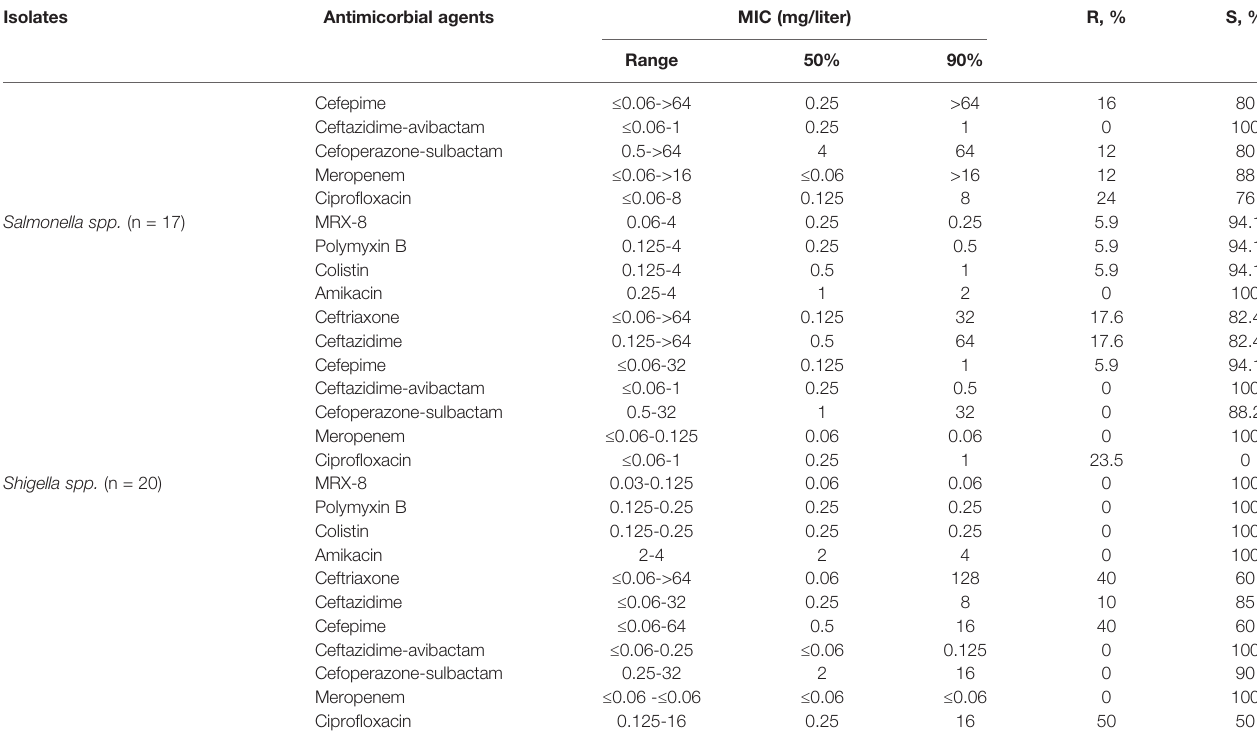
modi fi cation of LPS in outer membrane. Plasmid-mediated lipopolysaccharides (LPS) lipid A component of bacterial cell colistin resistance gene mcr-1 was fi rst discovered in E. coli membrane to increase the permeability of bacterial outer origined from animals in 2015, and this gene could transmit membrane (Vaara, 1992). Therefore, one of the main between different species through plasmids, mediating low levels mechanisms of bacterial resistance to polymyxins is the TABLE 4 | In vitro activity of MRX-8 and other comparator agents against 100 of Pseudomonas aeruginosa (mg/L). Isolates Antimicorbial agents MIC (mg/liter)